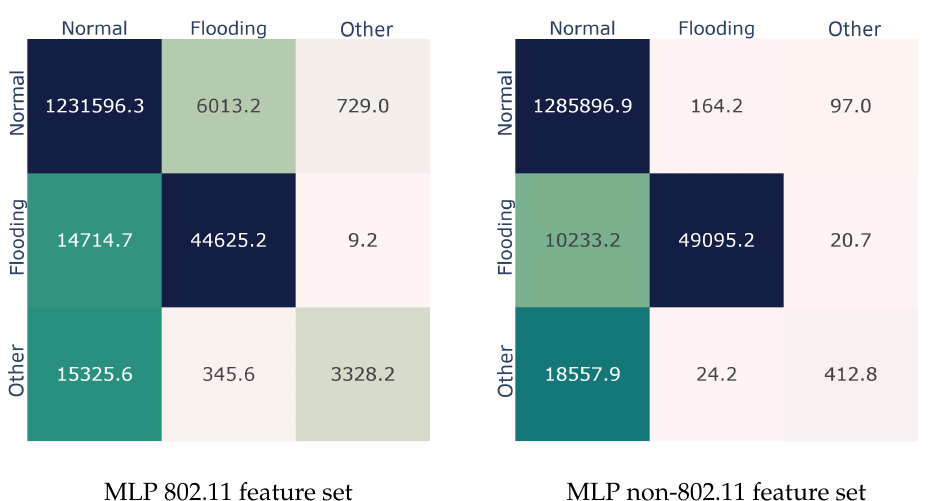
Figure 4. Best performer (MLP) confusion matrices per feature